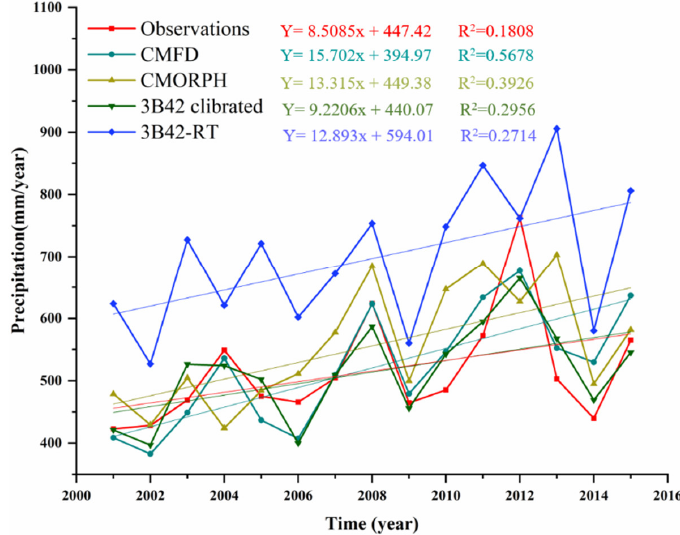
Figure 6. Average annual precipitation over the study period 2001–2005 determined from ground observations, and satellite derived products.